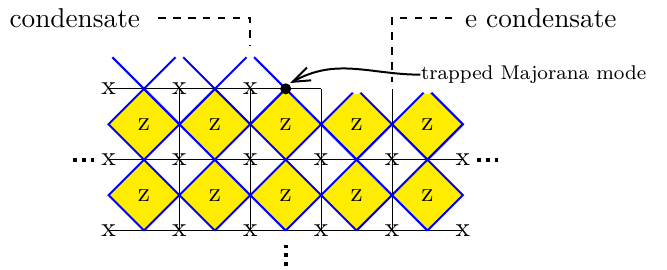
Figure 6 . An illustration of the e − m junction on the lattice. The black lines denote the lattice of Kitaev’s toric code model and the blue lines denote the lattice of the Wen plaquette model.